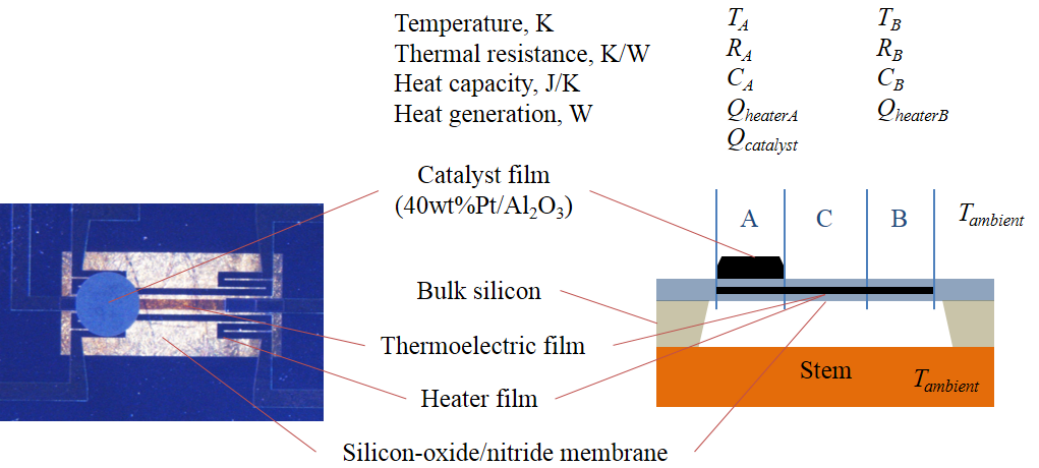
Figure 1. Optical image of the TGS (on the stem). Cross-sectional view of the TGS on the stem. Two sections of the heater meander line on the membrane are called sections A and B, and the center section of straight heater line is called section